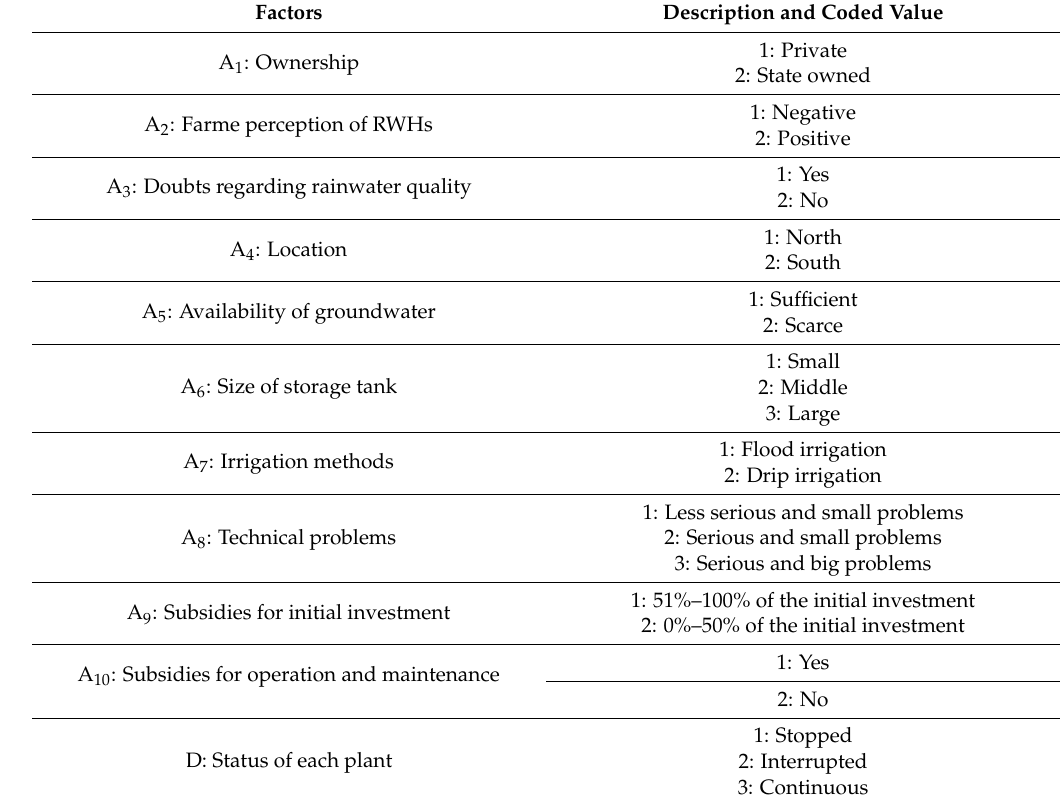
Table 3. Description and coded values of factors.